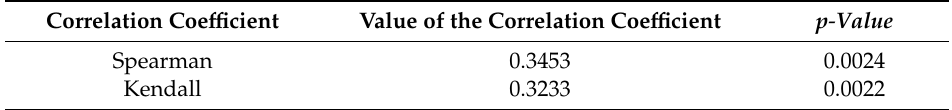
Table 3. The values of the correlation coefficients between the amount of costs incurred for innovations and the amount of cost savings of a family business.